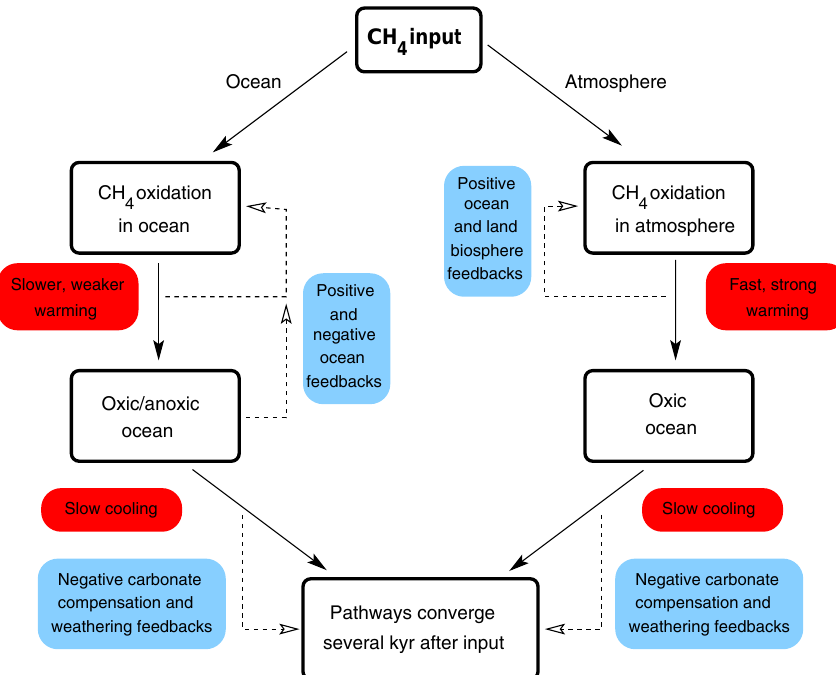
Figure 10. Comparison of pathways and feedbacks for all methane injection into the ocean or into the